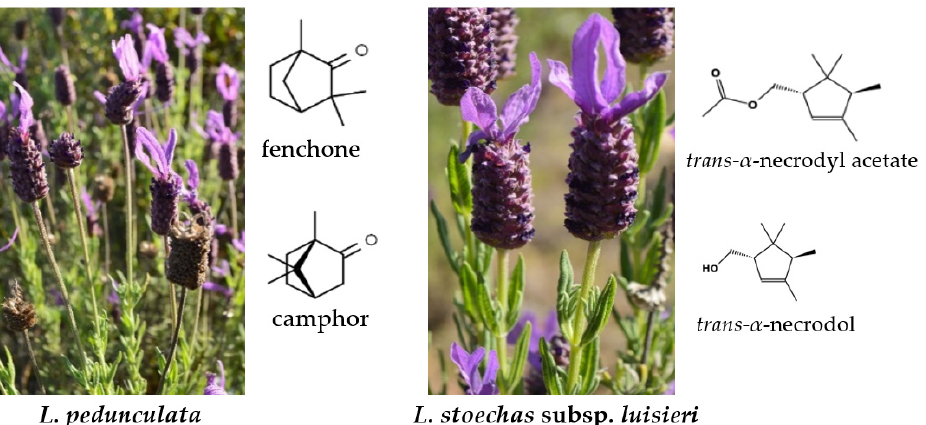
Figure 1. Morphological traits of Lavandula pedunculata and L. stoechas subsp. luisieri and its main ChemSpider (https://www.chemspider.com/StructureSearch.aspx, accessed on 23 March 2023).